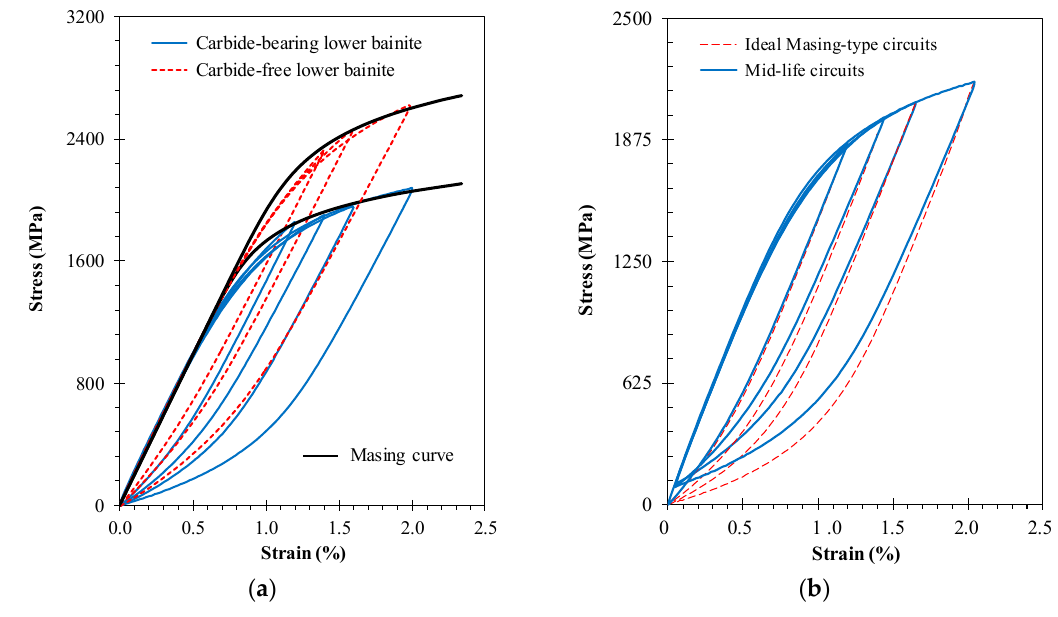
Figure 4. Mid-life circuits at different strain amplitudes with: ( a ) lower tips tied together for the carbide-bearing and carbide-free bainitic steels; ( b ) upper branches overlapped and ideal Masing-type circuits for the carbide-bearing bainitic steel.